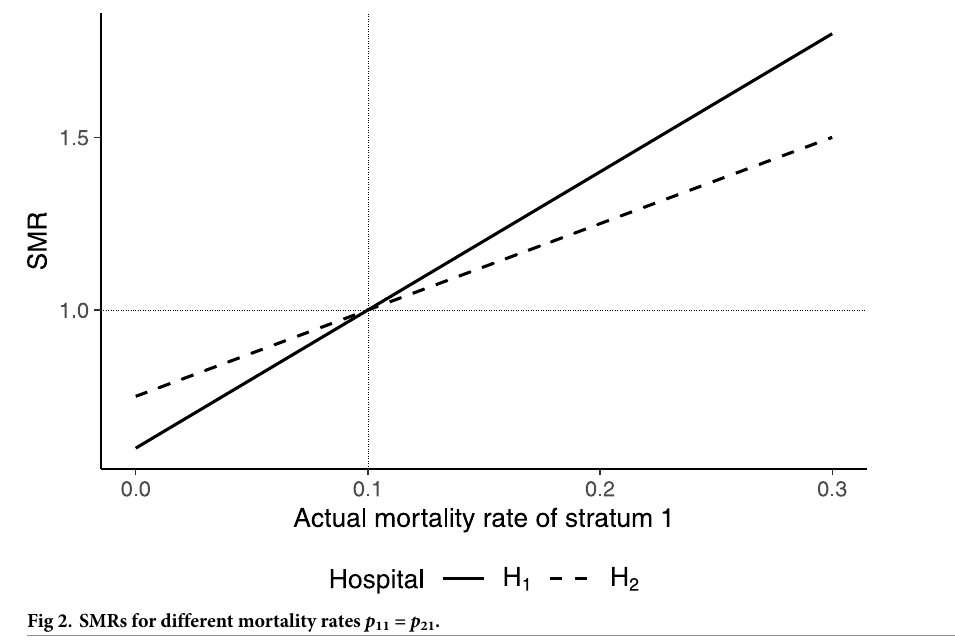
Fig 2. SMRs for different mortality rates p 11 = p 21